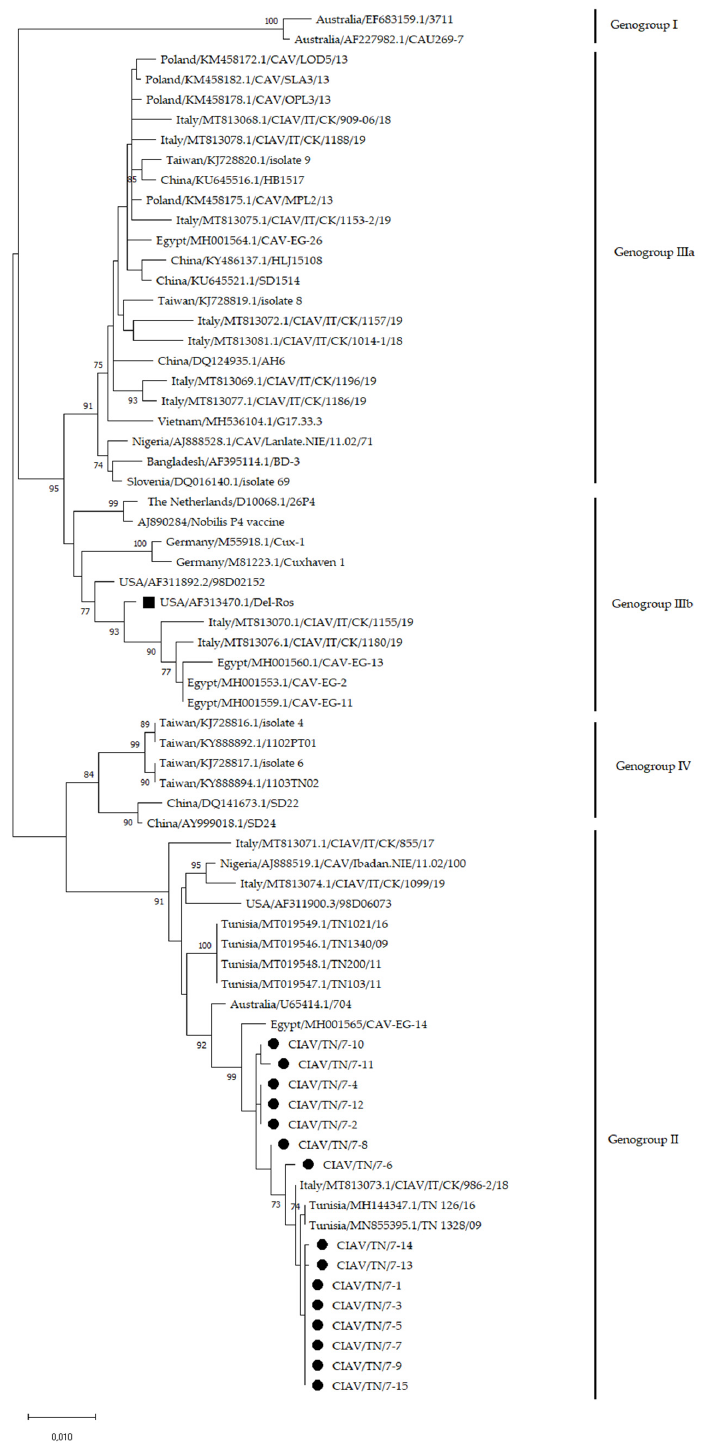
Figure 2. Phylogenetic tree based on the VP1 nucleotide sequence (1350 nt in length) of 15 Tunisian CIAV samples and CIAV strains from the GenBank database. New Tunisian CIAV sequences were marked with a black circle. Del-Ros vaccine strain was marked with a black square. Only bootstrap values ≥ 70 were reported. The tree was drawn to scale, with branch lengths in the same units as the evolutionary distances used to infer the phylogenetic